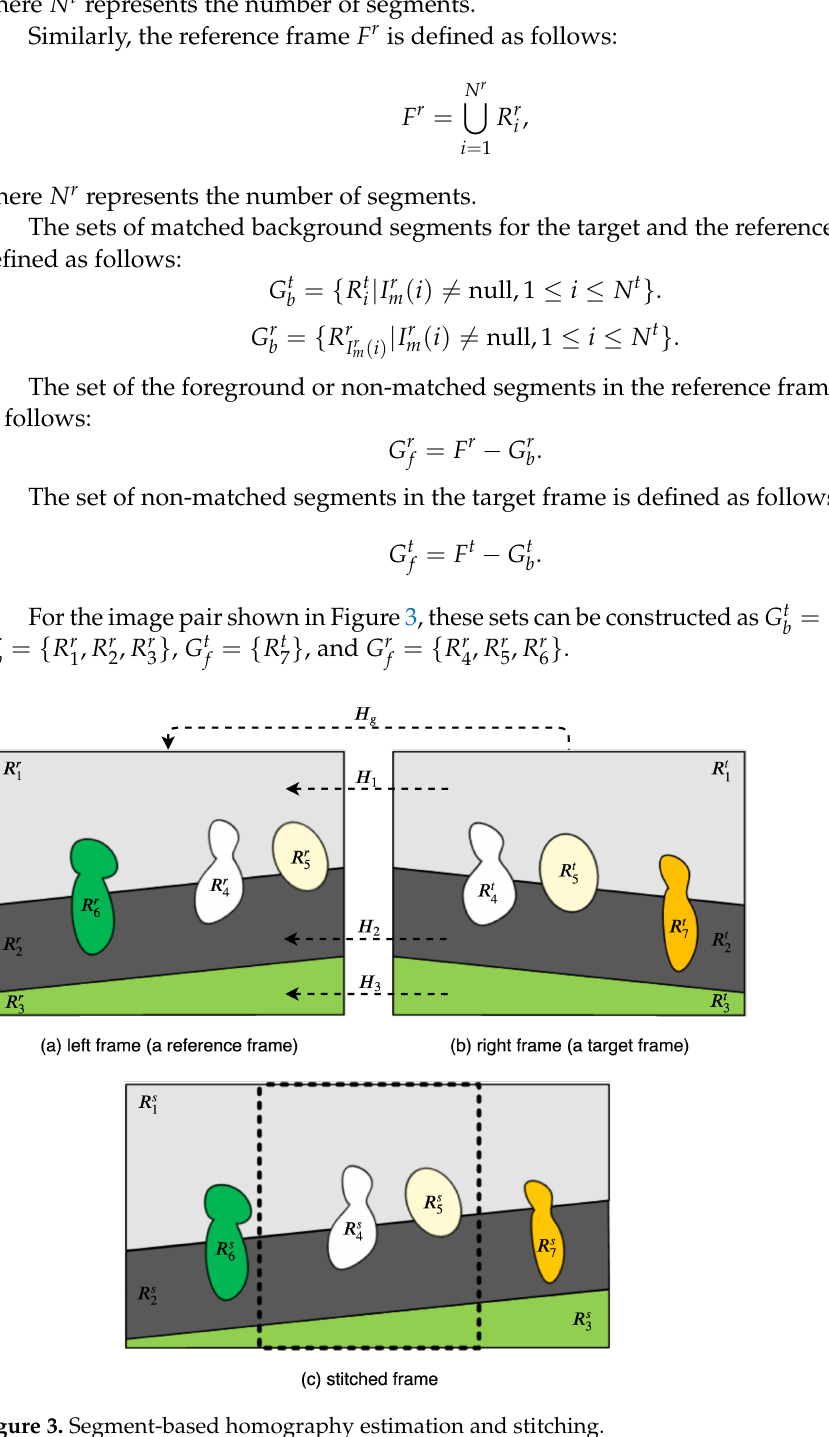
Figure 3. Segment-based homography estimation and